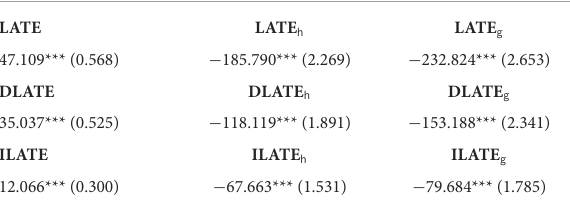
TABLE 7 Productivity, efficiency and welfare estimates on net returns—(lnGHC/ha). Impact on: welfare Technology frontier Inefficiency